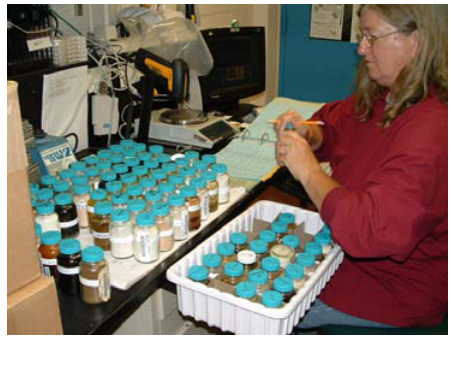
Figure 12. Recording weights of ‘bulk bottles’ containing vacuum dried extracts. Note multiple labels, non-contact laser barcode reader, and pan balance connected to computer work